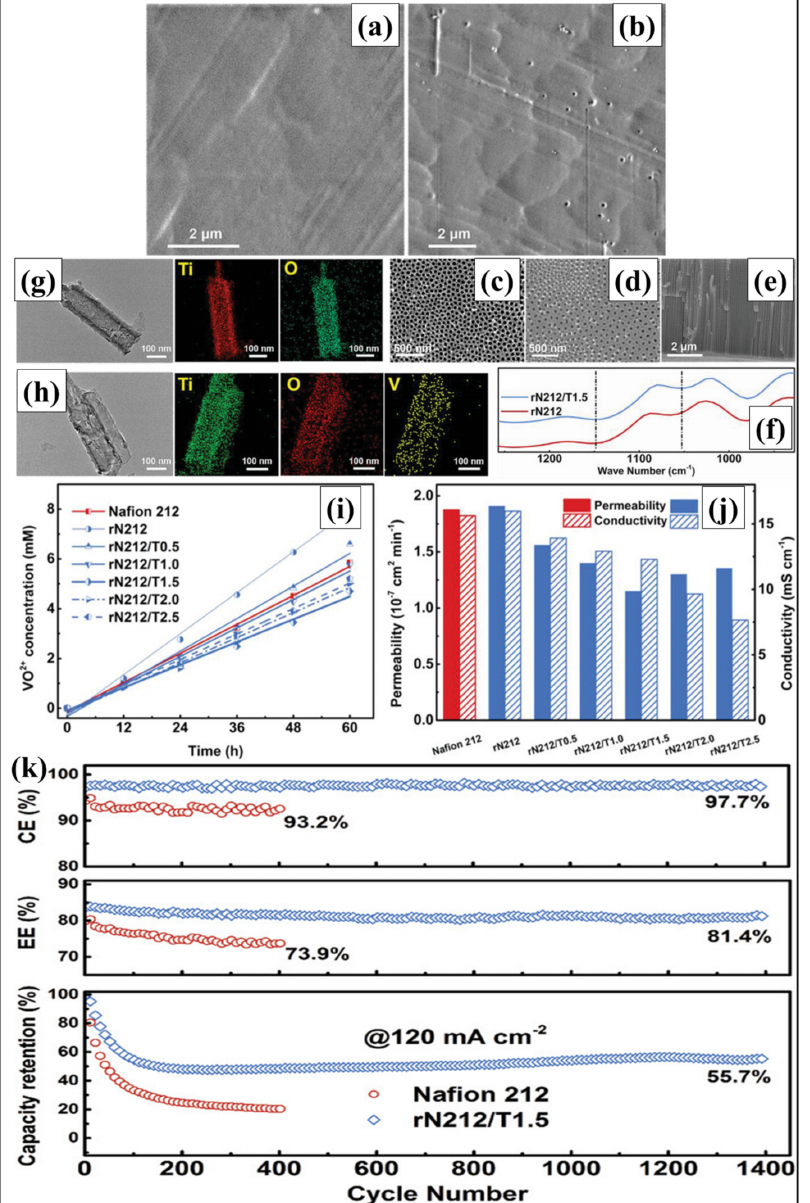
Figure 3. SEM cross-sectional view of ( a ) recast Nafion and ( b ) hybrid (rN212/T1.5) membranes. TiO 2 nanotube arrays: ( c ) top, ( d ) bottom, and ( e ) cross-sectional view of FE-SEM. ( f ) FTIR results of recast Nafion and hybrid (rN212/T1.5) membrane. ( g , h ) TEM and EDS mapping of TiO 2 nanotube— before and after soaking in VRFB electrolyte. ( i ) V 4+ ion cross-over, ( j ) vanadium permeability, and proton conductivity of membranes. ( k ) VRFB cell test of recast Nafion and rN212/T1.5 membranes. Reprinted with permission from ref. [68]. Copyright © 2020 WILEY-VCH Verlag GmbH & Co.